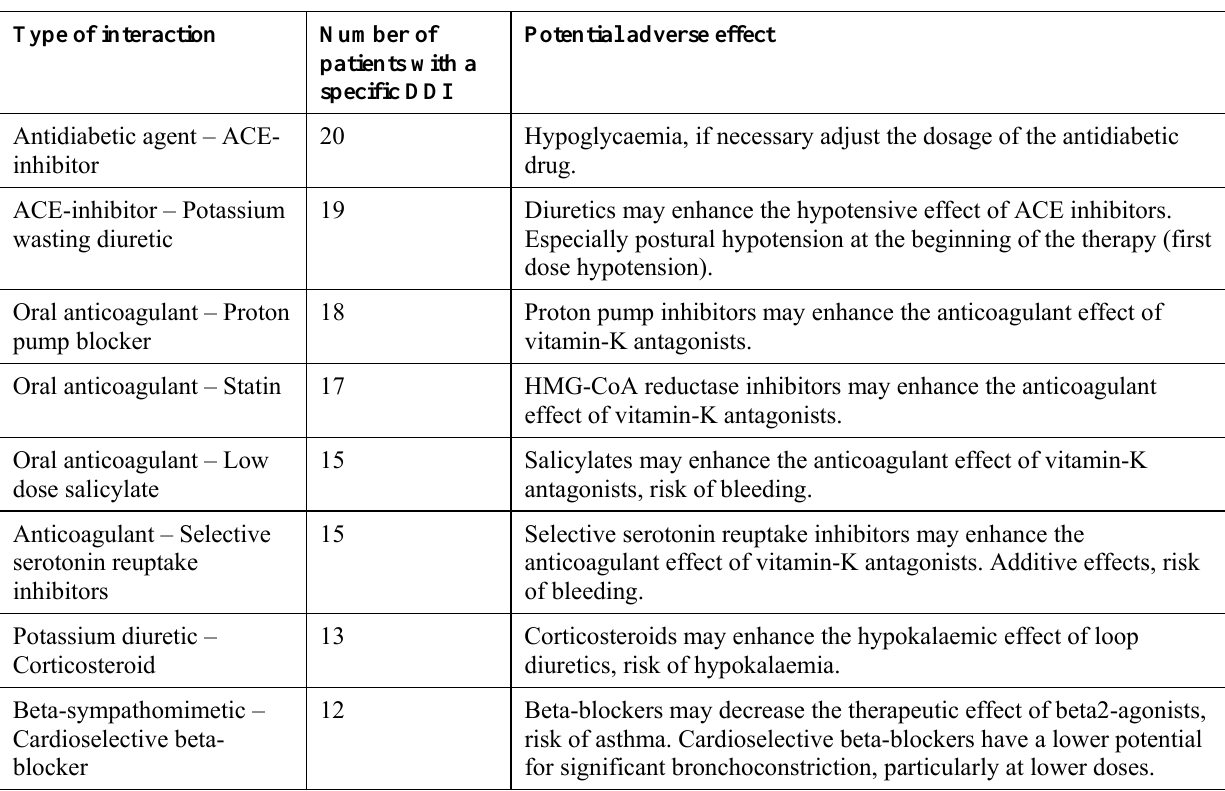
Table 2 Most prevalent drug-drug interactions (DDI). Type of